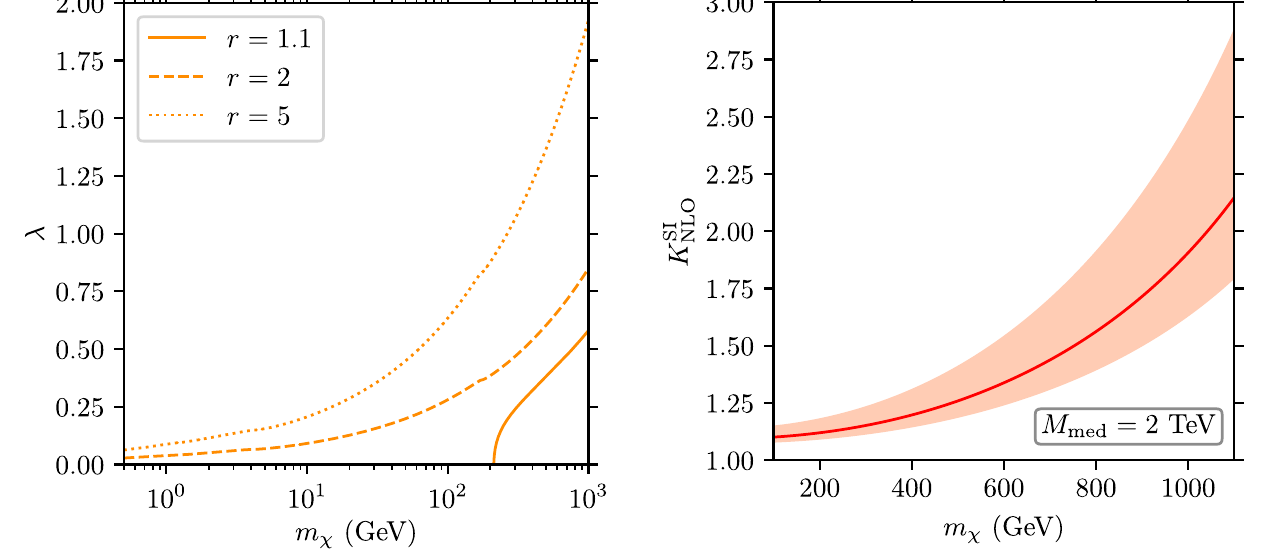
Fig. 5 Value of the t -channel coupling λ depending on m χ and r = M med / m χ for which the model correctly predicts the measured DM relic abundance Ω DM h 2 = 0 . 12 [46]. For r = 1 . 1 and m χ < 200 GeV, no phenomenologically viable configurations are found